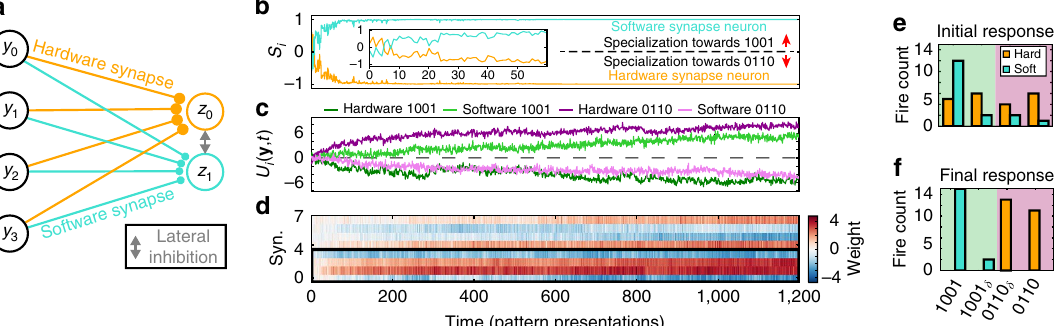
Figure 3 | Learning in a WTA network with a mixture of software and memristor synapses. ( a ) Diagram of the 2-neuron, WTA network used in this work. ( b ) Evolution of neuron specializations S i to patterns 0110 and 1001 as weights change over successive events, illustrating the interplay between the two neurons. Inset: close-up of first 60 trials. ( c ) Computed membrane potentials of each neuron to both prototype patterns according to their weights at every trial illustrating the intrinsic pattern preferences of each neuron, that is independent of their interaction in the WTA network. ( d ) Evolution of hardware (synapses 0–3, enclosed in thick, black frame) and software (synapses 4–7) weights. ( e , f ) Responses of the WTA network to the initial ( e ) and final ( f ) 41 input samples. The fire count of both the hardware synapse neuron (orange) and the software synapse neuron (turquoise) is shown for patterns 0110 and 1001, and patterns that differ from these prototypes in one position (0110 d and 1001 d ). The different pattern groups are perfectly segregated by the end of the